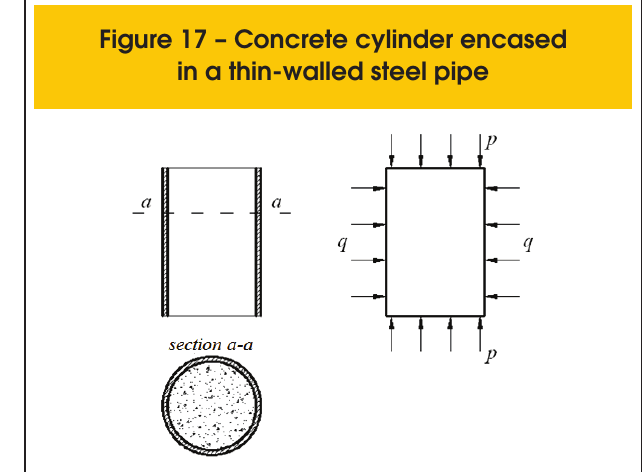
Figure 17 – Concrete cylinder encased in a thin-walled steel pipe